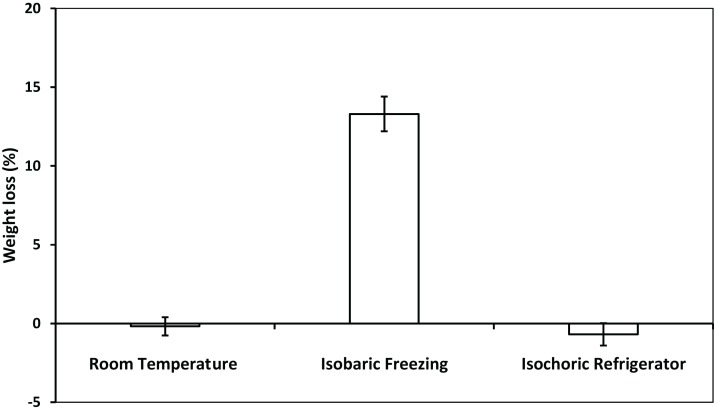
The weight loss of potato after room temperature preservation, isobaric freezing and isochoric refrigeration.The weight loss was obtained by comparing the weight of the samples before and after each treatment. The surface water on the sample was absorbed by filter papers before weighing. The weight loss of five samples were measured for each treatment. The error bars represent the standard deviation of five samples.